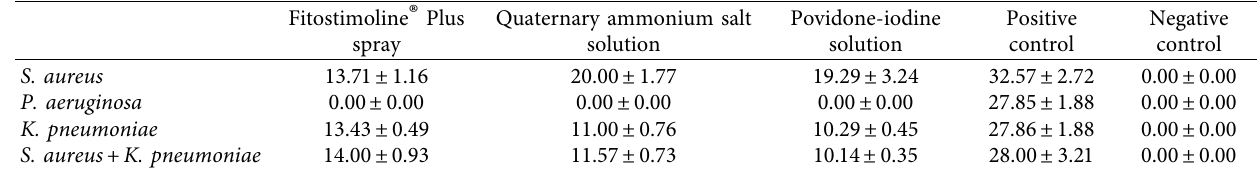
Table 1: Summary of agar disk diffusion assay inhibition areas